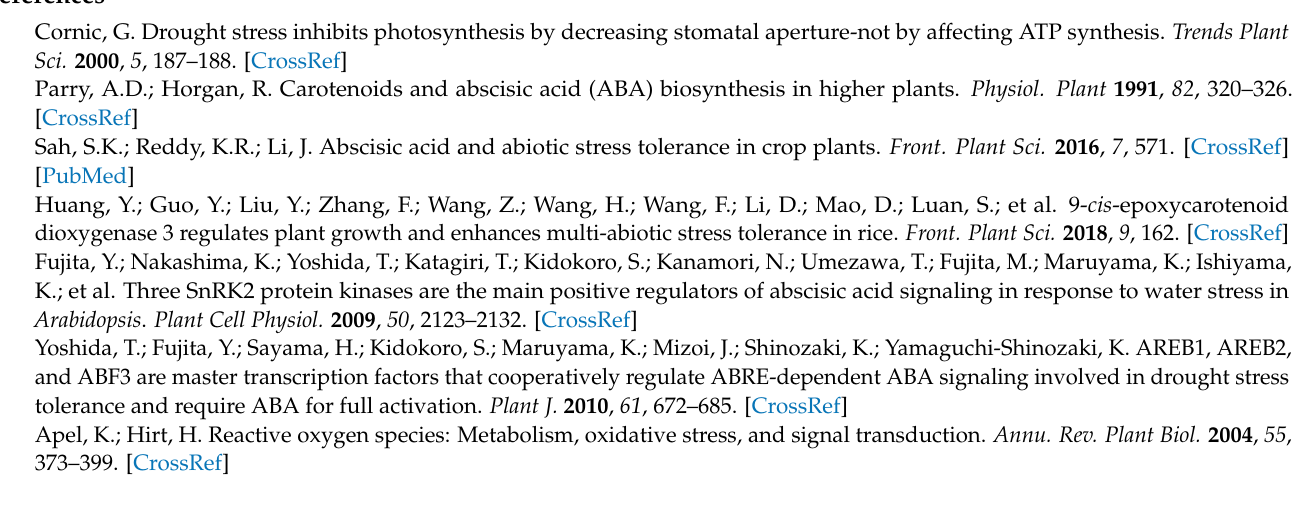
results, Table S3: Garlic genes identified in the study, Table S4: The DEGs identified in the garlic leaves after drought treatment, Table S5: GO terms analysis of the DEGs from drought-treated leaves, Table S6: KEGG pathways enriched in drought